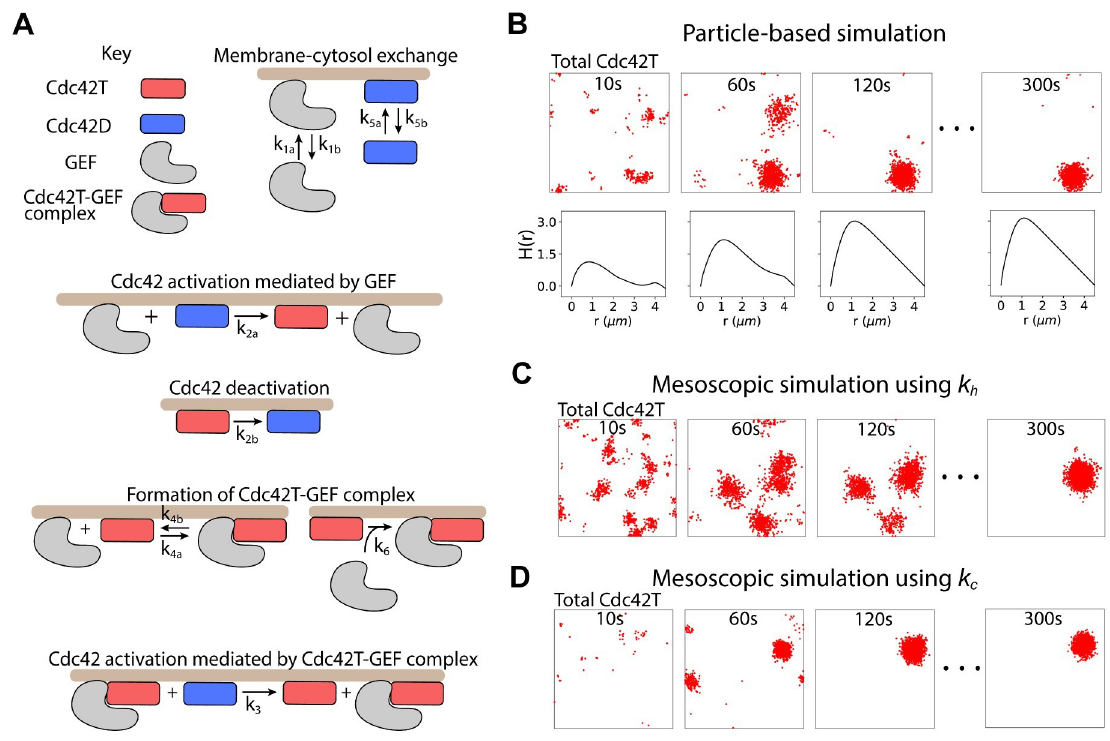
Fig 3. Cdc42 polarization simulated with particle-based simulations and spatial Gillespie simulations using k model for polarization in budding yeast. Species that are not bound to the membrane (brown), dwell in the cytosol. Membrane and cytosol are represented in the simulations as juxtaposed 2D squared domains. (B) Time series of a particle-based simulation of the polarization model in (A) . In each snapshot, red dots show the positions on the membrane of all active Cdc42 molecules (Cdc42T and Cdc42T-GEF). The lower panels in (B) show a quantification of active Cdc42 clustering using the H( r ) function (see Methods for details). (C, D) Spatial Gillespie simulations using k (C) and k (D) with the same model parameters as the particle-based simulation in (A) and grid element size h = 5 ρ . h c Pseudo-coordinates for each molecule are randomly sampled from the containing grid element and displayed as a red dot to facilitate comparison with particle-based simulations. Model parameters are presented in Table